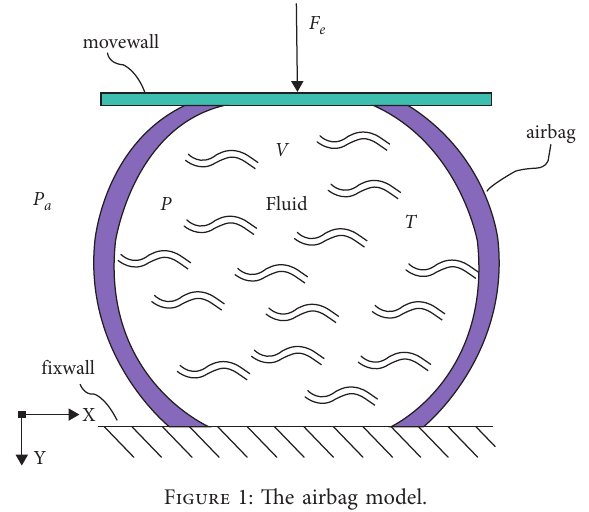
Figure 1: The airbag